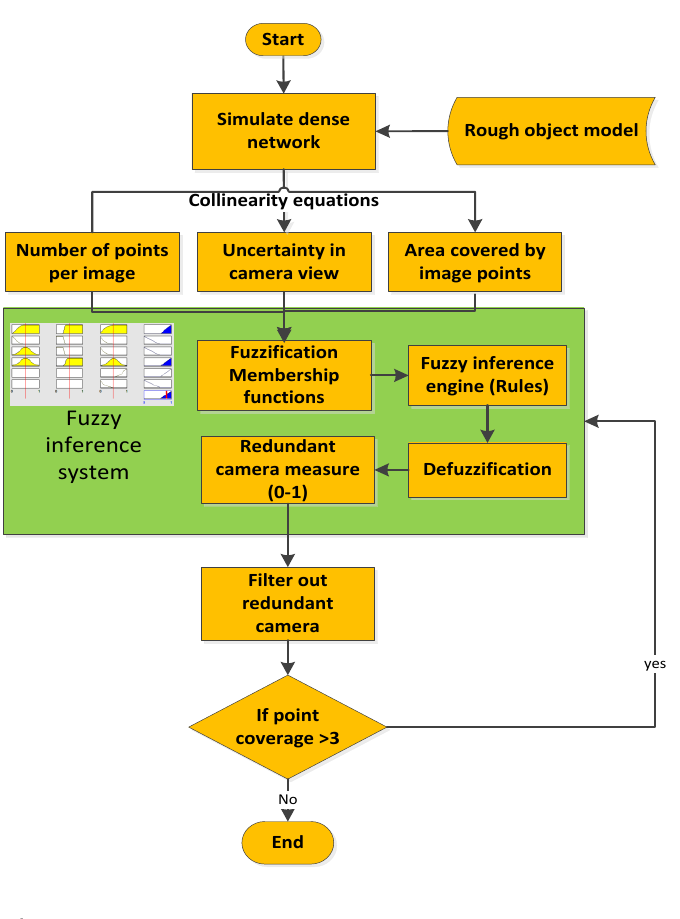
Figure 7. A methodology flowchart of filtering with